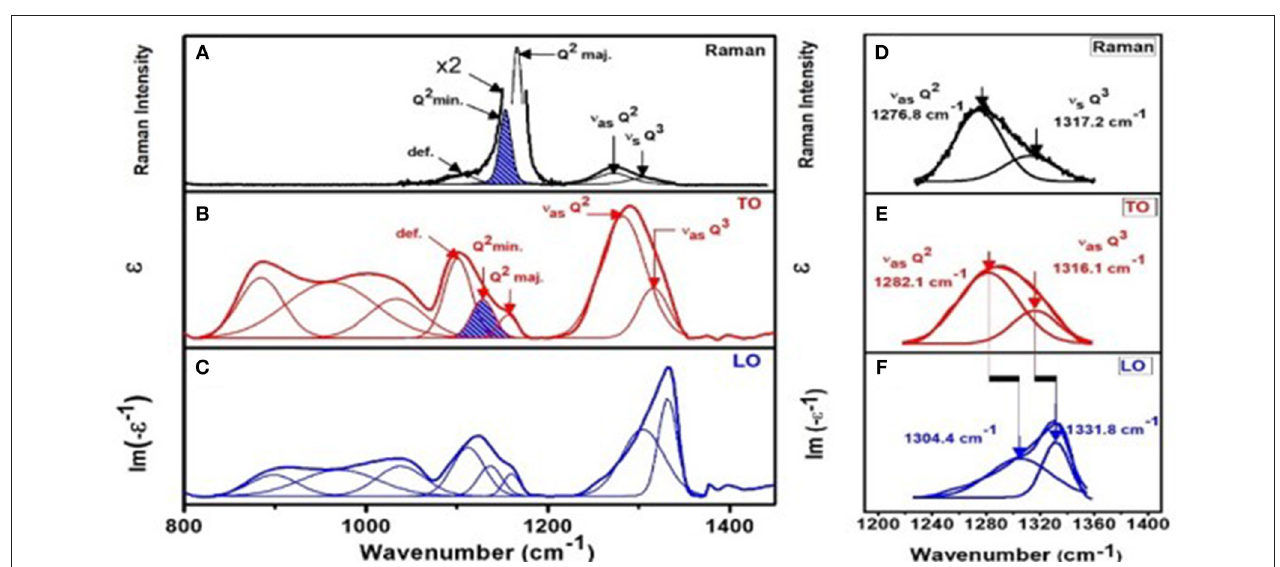
FIGURE 4 | Correlating (A) Raman scattering with (B) IR TO response ( ε ) and (C) IR LO response [Im (-1/ ε )] for NaPO 3 glass. Note that the two minority modes (Q 2 min. mode and def. mode) associated with the majority mode near 1,166 cm − 1 mode are weakly excited in Raman scattering but strongly in IR response (B,C) . Please note we have enhanced the two minority modes by a factor of 2 in plotting the data to make these features visible in (A) . (D) shows a blow up of the two high frequency optic modes from (A) while (E) and (F) give the same two optic modes from (B) and (C) respectively. Note, one observes an LO-TO splitting associated with the two highest frequency optic modes, Q 2 asymmetric and Q 3 asymmetric as shown in (E) and (F) .